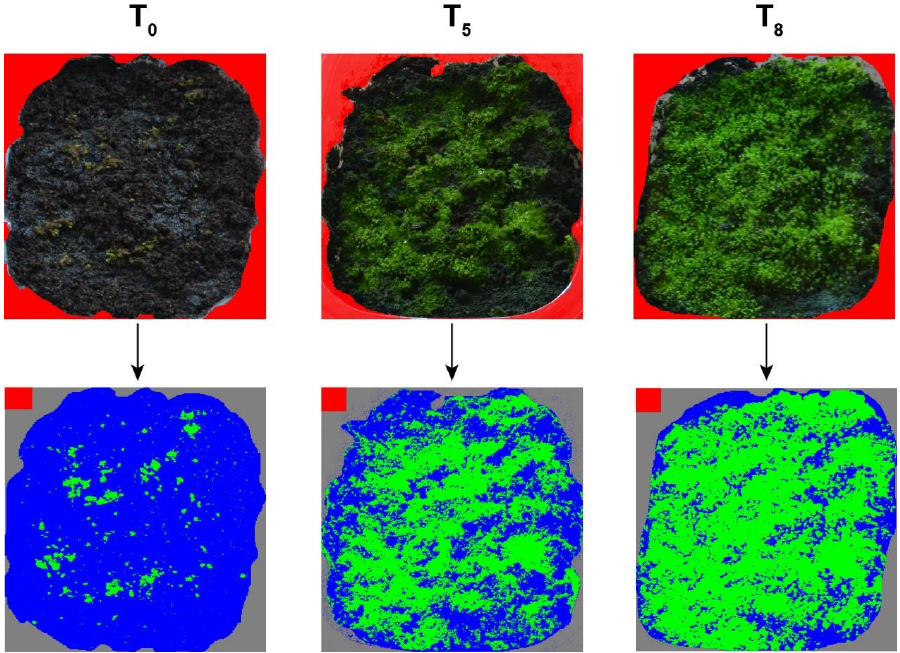
Figure 2. Images of Tortella nitida at time 0 (T 0 ), 5 (T 5 ) and 8 (T 8 ) weeks and their corresponding pixel coverage analysis.